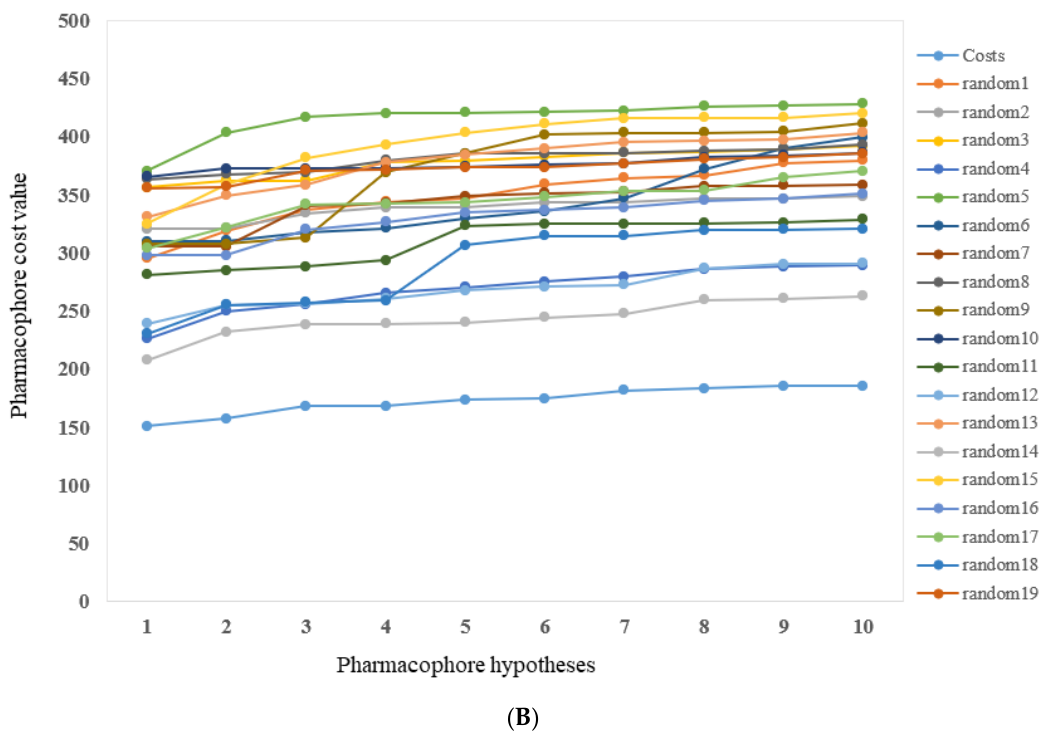
Figure 3. ( A , B ): The difference in correlation and total cost values of hypotheses between a Hypo1 spreadsheet and 19 random spreadsheets.